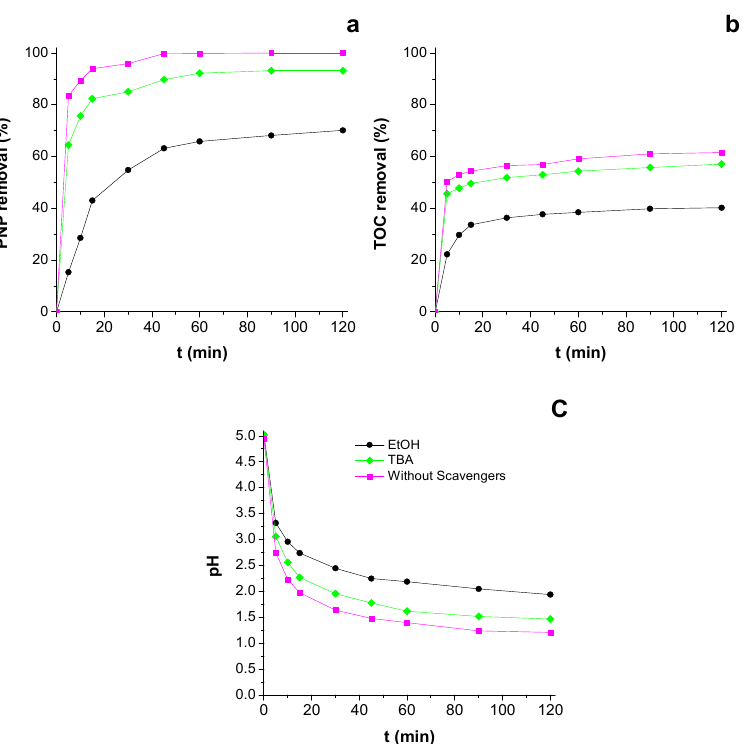
Figure 6. PNP ( a ) and TOC ( b ) removals and pH evolution ( c ) during the persulphate oxidation process activated by radiation in presence or not of scavengers ([PNP] o = 500 mg/L, pH = 5.0, T = 70 °C, I = 500 W/m 2 , [S 2 O 82 − ] o = 6.4 g/L and (persulphate:scavenger) o,when used = 1.7 mol/mol). Dhaka et al. [34] also verified, under acid and neutral pH conditions, a higher reduc- tion of methyl paraben removal in presence of EtOH (decay from 100% to 54.3–52.7%) than with TBA (from 100% to 80.2–77.1%). Still, Zhou et al. [21] observed, at pH 3 and 7.0, a much greater decrease of reduction of bis(2-cloroethyl) ether, after 60 min of reaction, in presence of EtOH (decrease from 90.7 to 53.6% and from ~73 to 46.4%, respectively) than with TBA (decrease from 90.7 to 88.7% at pH = 3.0 and, from ~73 to ~62% at pH = 7.0); however, in alkaline conditions (pH = 10) the decay of the pollutant removal also occurs in the presence of both radical quenchers but was higher in presence of TBA than EtOH (from ~83 to ~46 and ~66%, respectively). The authors concluded that in acid and neutral conditions the sulphate radical dominated, but in alkaline medium is the hydroxyl radical that prevails.